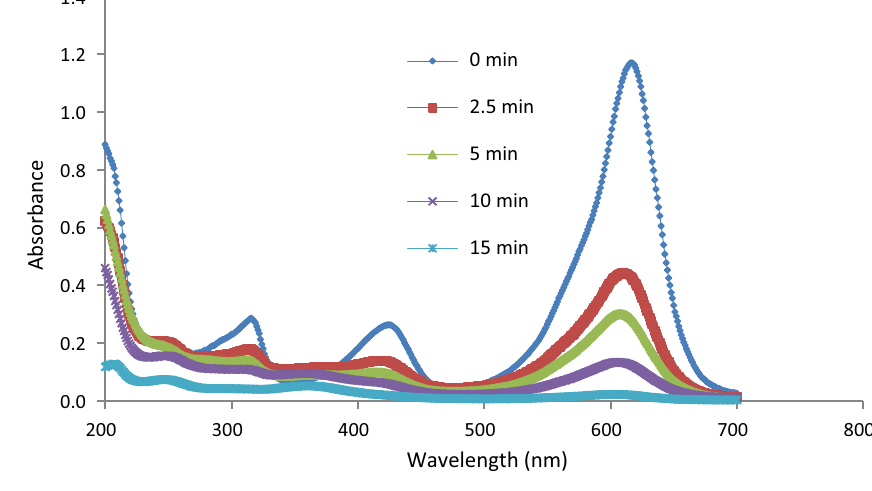
Fig. 10 The absorption spectra of MG degradation at typical time (initial MG concentra- tion = 200 mg/L; solution pH = inherent (3); current density = 10 mA/cm2; H 2 O 2 dosage = 50 mg/L)